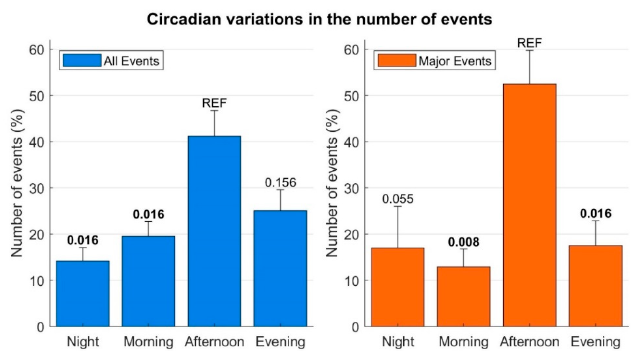
Figure 1. Distribution of events during the day. Bars: average hourly incidence of events computed across different years. Whiskers: standard error. Solid line: moving average.